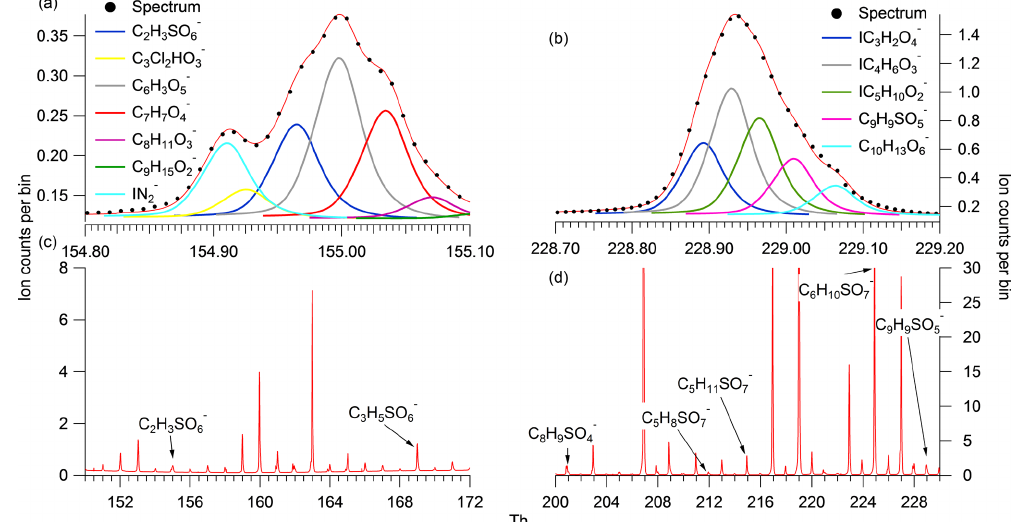
Figure 1. Panels (c) and (d) display the average campaign mass spectrum for different regions on the spectra, which are further expanded to specific HR fittings for individual peaks in panels (a) and (b) . Table 1. SCOs identified at the Changping site with their masses, chemical names and potential